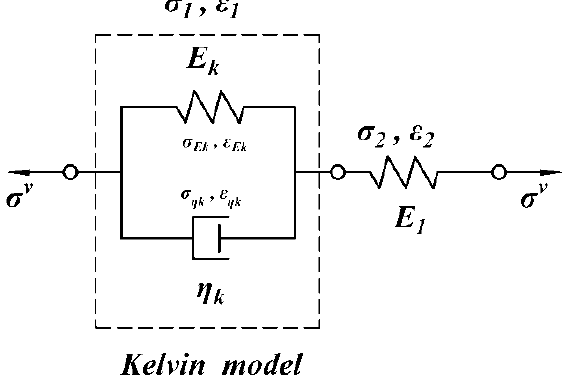
Figure 6. Schematic of the standard linear solid (SLS) model.